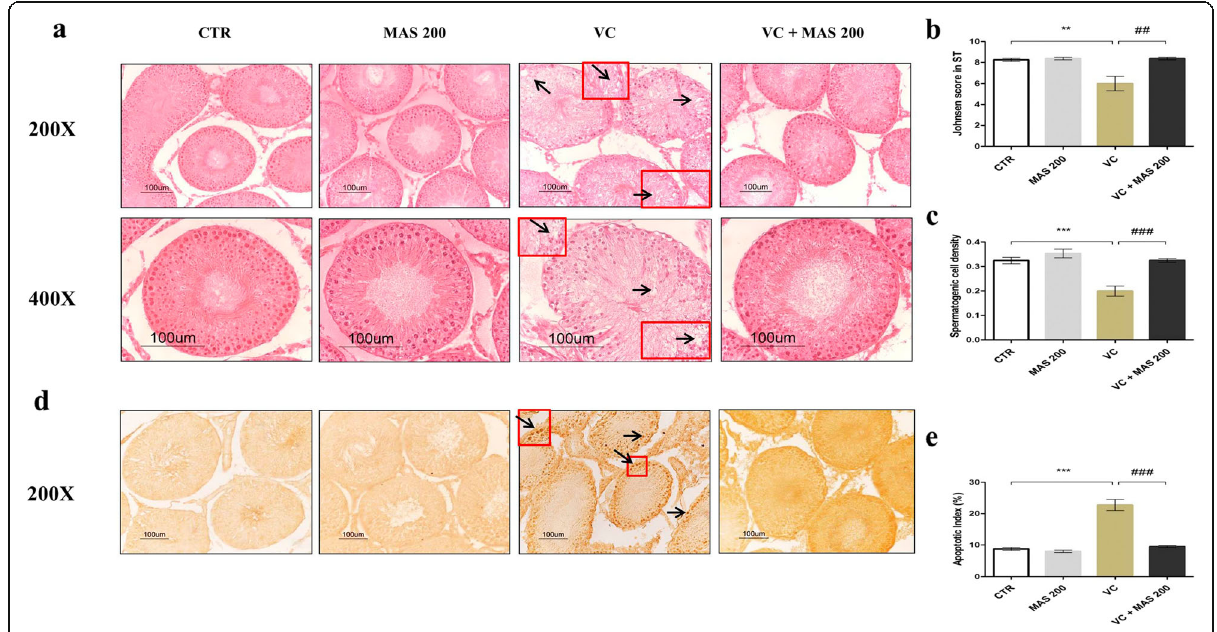
Fig. 1 Effect of MAS on testicular histopathology and germ cell apoptosis based on with hematoxylin and eosin (H&E) staining, and terminal deoxynucleotidyl transferase-mediated dUTP nick-end labeling (TUNEL) staining of varicocele (VC)-induced male SD rats. a Hematoxylin and eosin stain showing scanty spermatogenic cells, irregular seminiferous tubules and seminiferous tubules with vacuoles in the VC group (arrowhead; a ). b Johnsen ’ s score in seminiferous tubules compared among different groups. c Spermatogenic cell density of seminiferous tubules. ( d ) TUNEL staining. Black arrows showed TUNEL-positive cells (arrows; d ). e Quantification of apoptotic index (AI) expressed as total positive cells/ seminiferous tubule X 100. Data are presented as mean ± SEM. The differences were tested by one-way ANOVA followed by Tukey ’ s post hoc test; n = 10 for each group. * Significant at P < 0.05; ** Significant at P < 0.01; *** Significant at P < 0.001- versus CTR group; # Significant at P < 0.05; ## Significant at P < 0.01; ### Significant at P < 0.001- versus VC group. CTR: control; MAS 200: MAS 200 mg/kg p.o.; VC: varicocele; VC + MAS 200: MAS